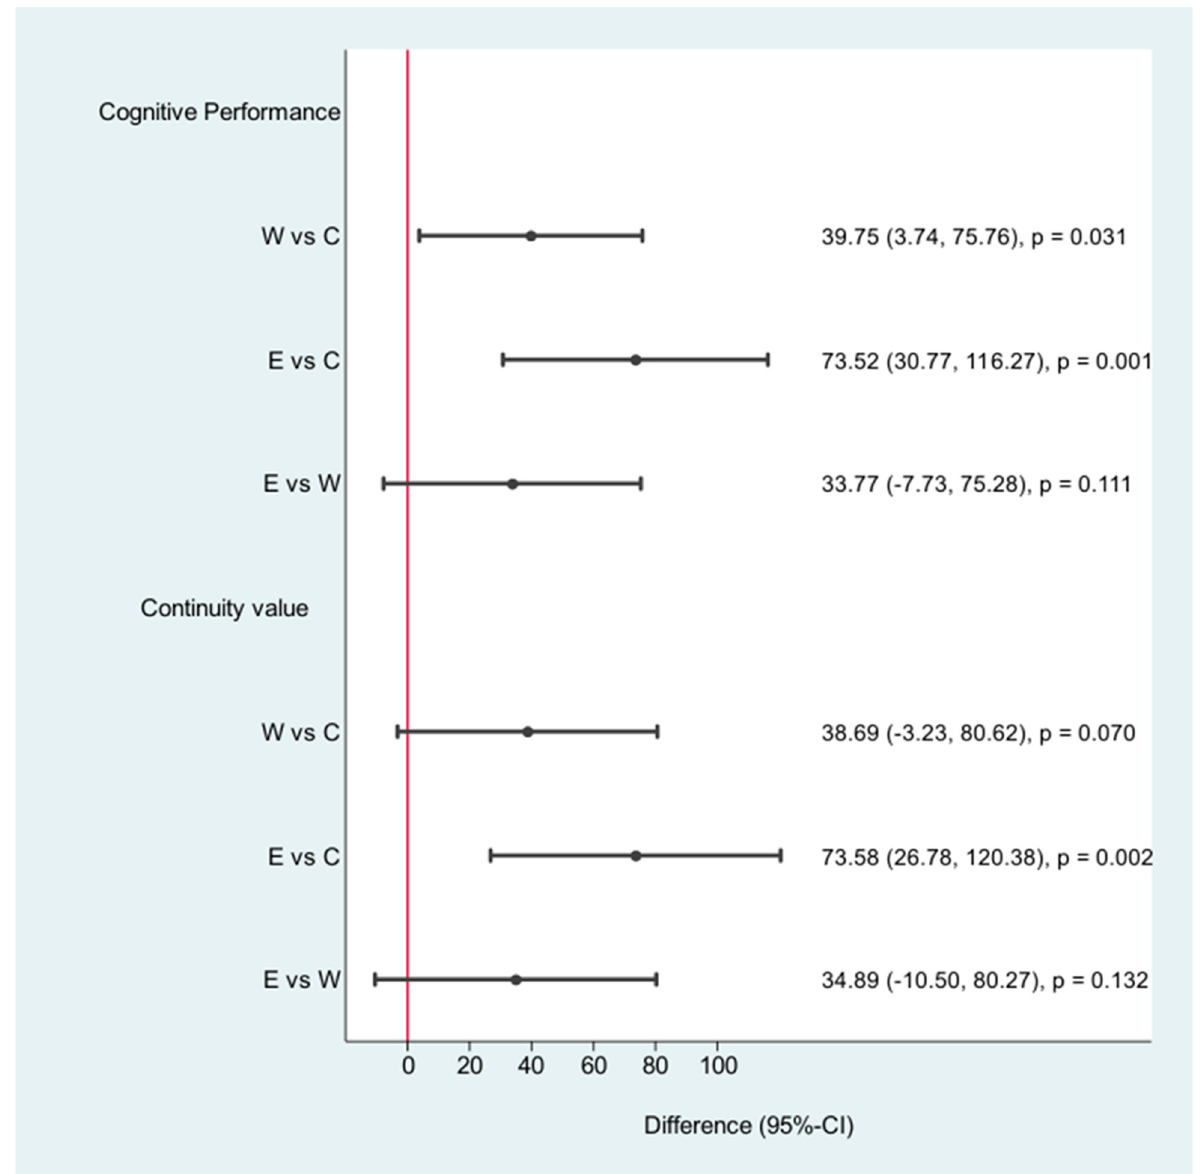
Figure 4. Cognition: differences after the intervention; W = walking, C = control, E =